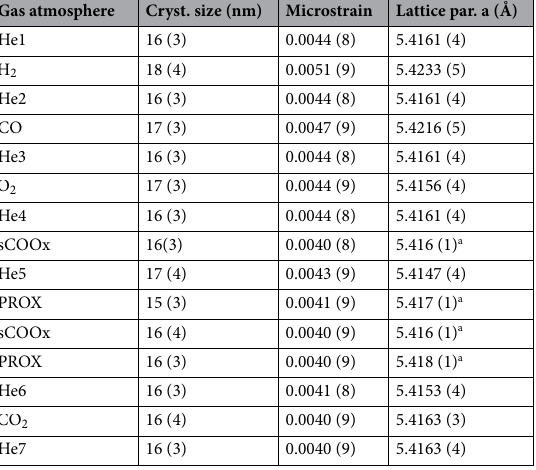
Table 2. Fit parameters of CeO 2 structure for Au/CeO 2 sample from 9 diffraction peaks. The last figure regression error is given in parenthesis. All values correspond to temperature 150 °C. a The value corrected for the light-off temperature effect.